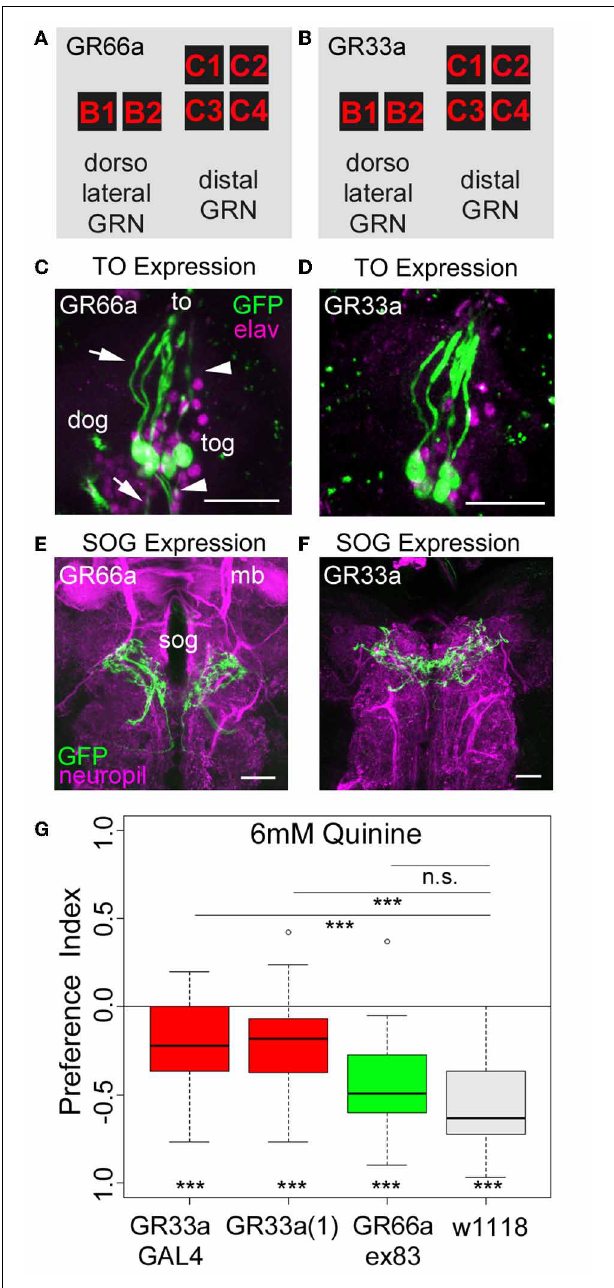
FIGURE 3 | Gr33a receptors but not Gr66a receptors are required for quinine avoidance. (A,B) GR66a-GAL4 and GR33a-GAL4 are expressed in the same set of six GRNs of the TO, schematically represented for GR66a-GAL4 (A) and GR33a-GAL4 (B) . Two of the neurons belong to the dorsolateral group, called B1 and B2, and the other four to the distal group, called C1–C4. This suggests that both receptors are co-expressed in the same set of bitter sensing GRNs. (C,D) The GFP expression for GR66a-GAL4 (C) and GR33a-GAL4 (D) crossed to UAS-mCD8::GFP is shown in the terminal organ (to). The two GRNs B1 and B2 of the dorsolateral group have their cell bodies located within the dorsal organ ganglion (dog; arrow). The four GRNs C1–C4 of the distal group have their cell bodies in the terminal organ ganglion (tog; arrowhead). Anti-GFP